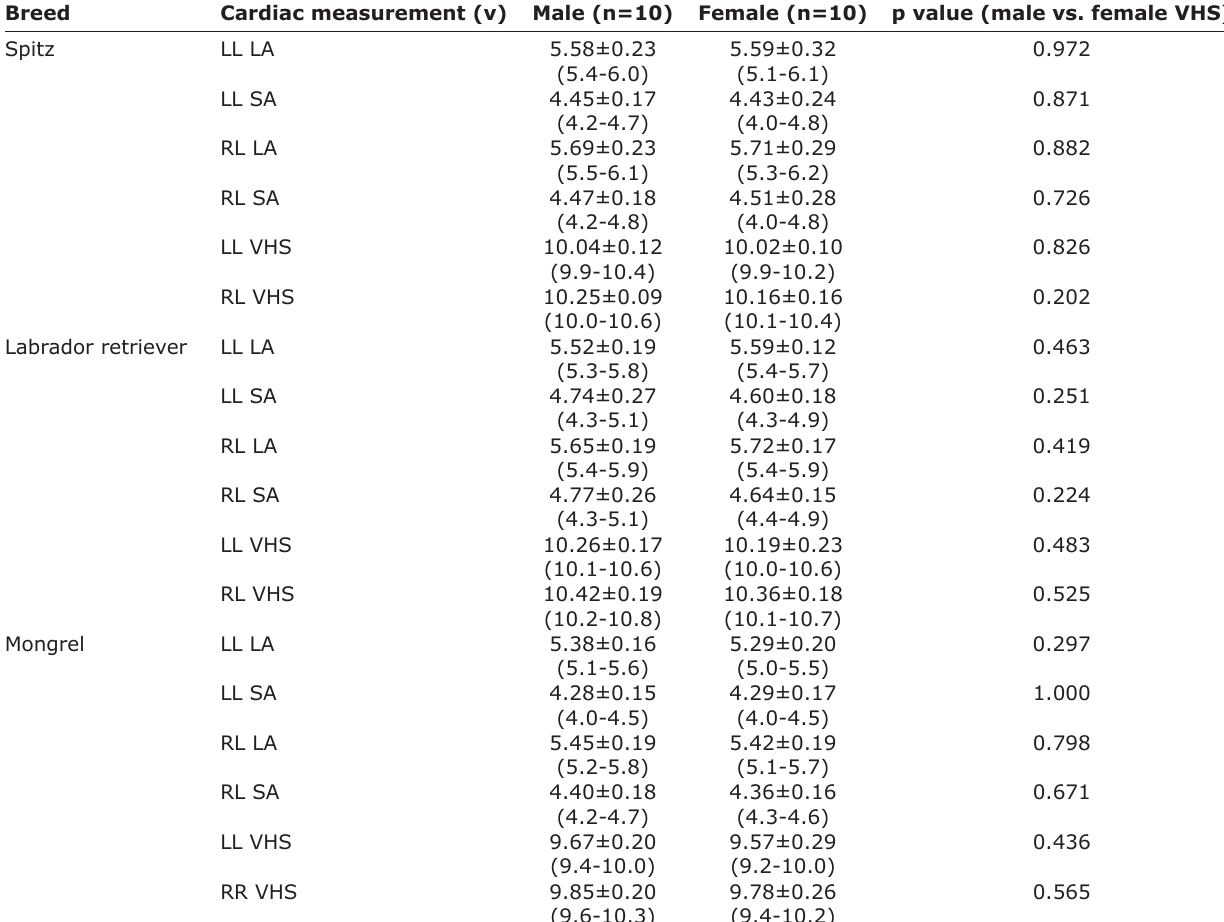
Table-4: Mean (±SD) of cardiac measurements in male and female dogs within each breed. Breed